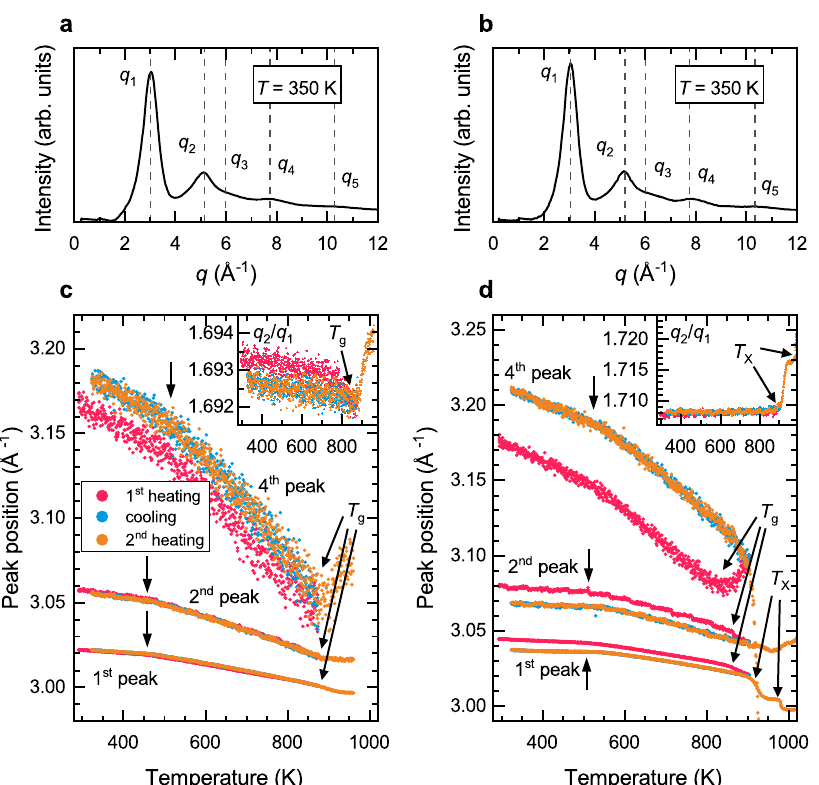
Fig. 1 XRD radial intensity pro fi les of QNb and QMo and their temperature evolution. After azimuthal integration of the 2D diffraction images, the 1D diffraction patterns display fi ve broad peaks for both a QNb and b QMo. All peaks of c QNb and d QMo shift to lower q values as temperature increases. A change in the shift rate is observed at the dilatometric transition temperature and marked with arrows. At temperatures far below the glass transition temperature, the changes are reversible. After the fi rst heating run, there is a rearrangement of the SRO, which is re fl ected in the fourth peak position. Each inset shows the position ratio of the fi rst two peaks as a function of